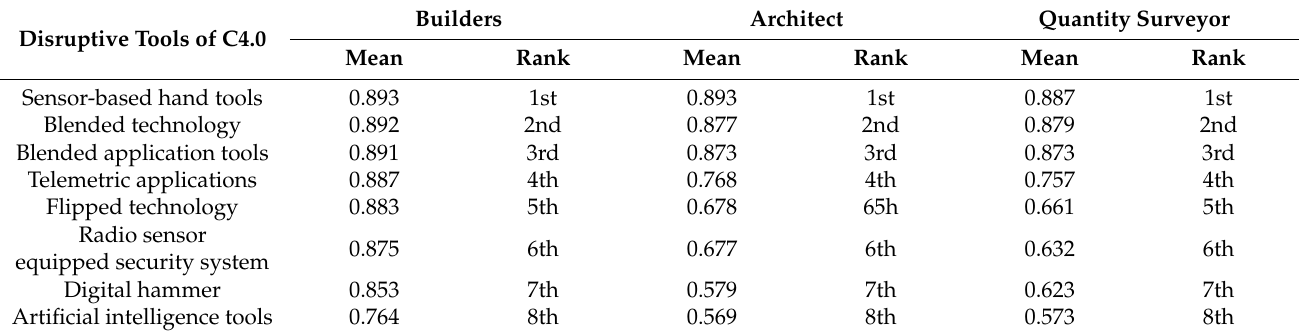
Table 11. Disruptive Tools of C4.0 in Achieving Inclusive Sustainable Innovation for Technological Development. Builders Architect Quantity Disruptive Tools of C4.0